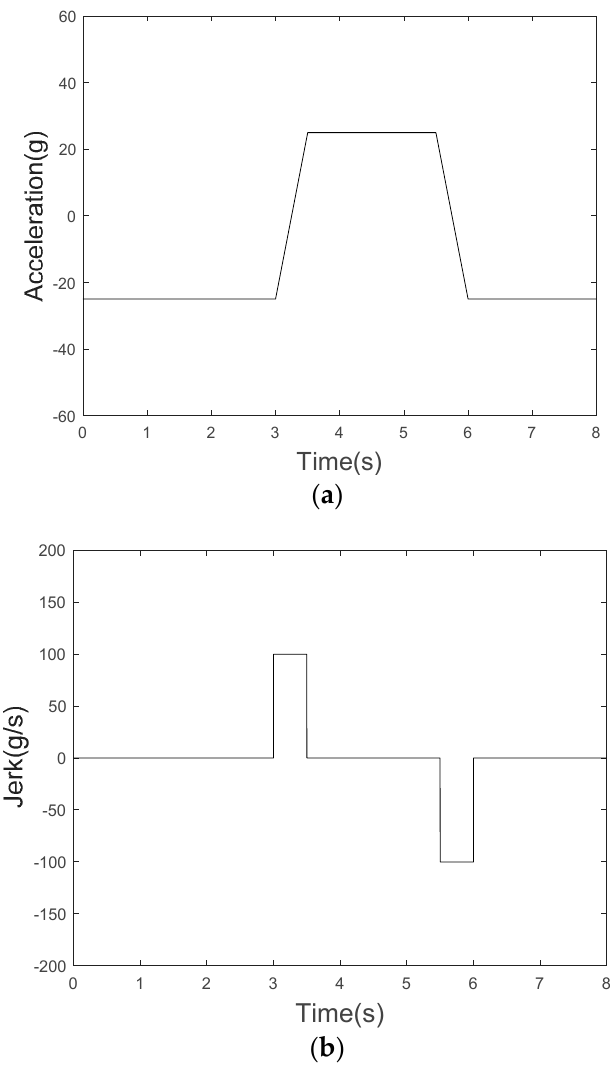
Figure 3. Trajectory of the receiver relative to the GPS satellite. ( a ) Acceleration model for highly dynamic motion; ( b ) jerk model for highly dynamic motion [28].